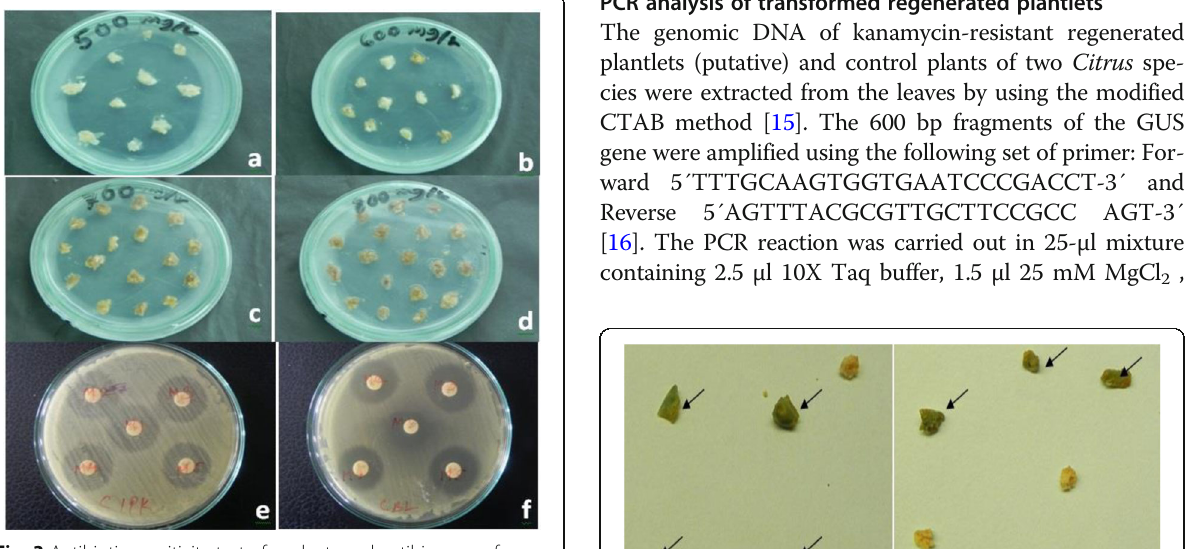
Fig. 3 Antibiotic sensitivity test of explants and antibiogram of Agrobacterium strains. After seven days of inoculation of explants remained fresh ( a ) at 500 mg/l cefotaxime but became pale ( b ) at 600 mg/l cefotaxime and died at 700 mg/l, 800 mg/l (c, d). Clear zone were found at 500 mg/l cefotaxime in case of both strains PsCIPK ( e ) and PsCBL ( f ).